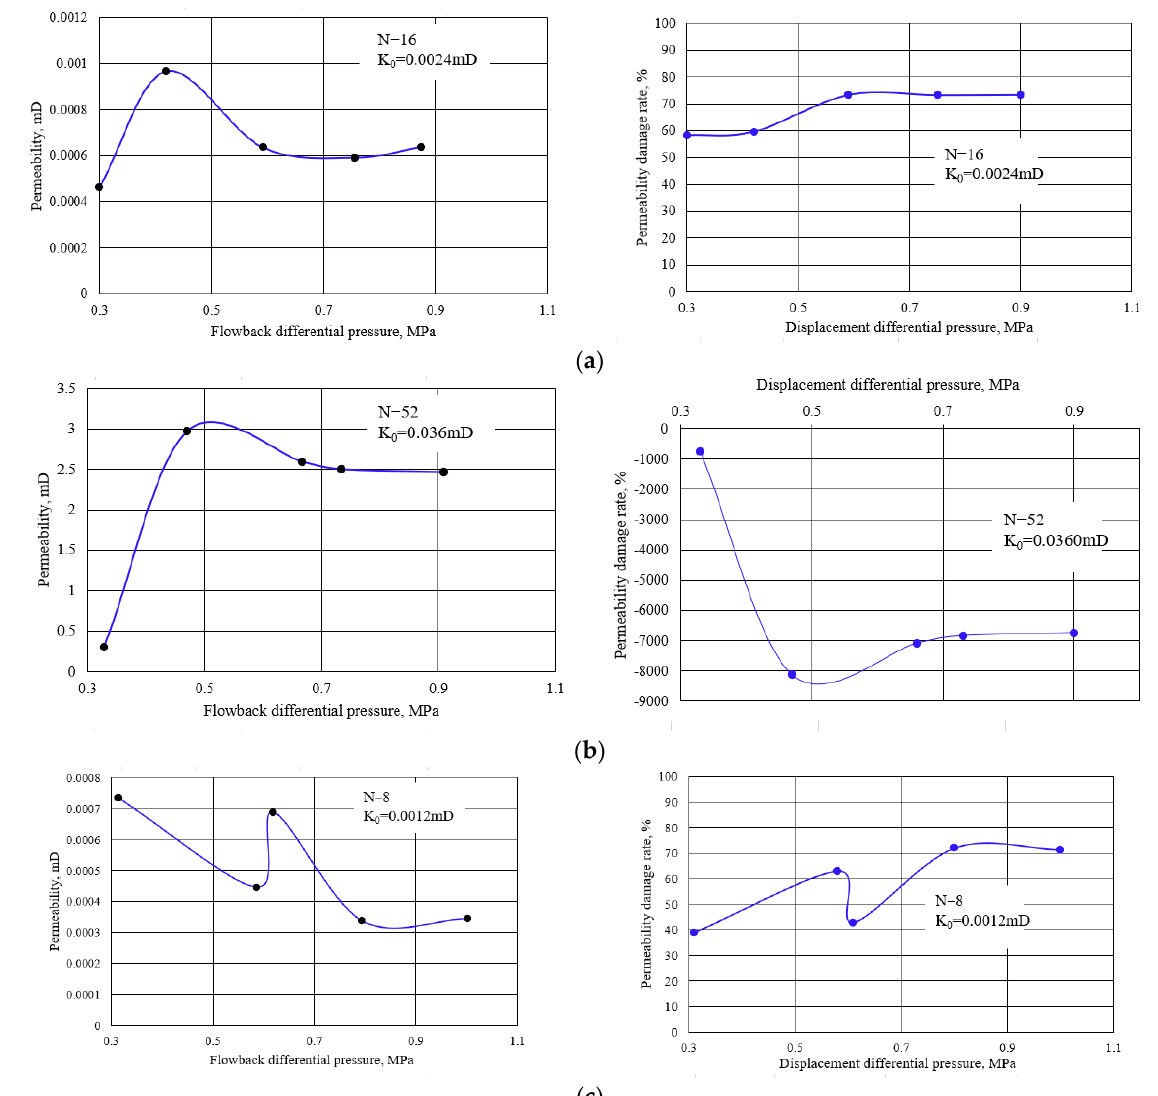
Figure 6. The shale permeability and permeability damage rate under different flowback pressure differences. ( a ) N-16, ( b ) N-52, and ( c ) N-8.